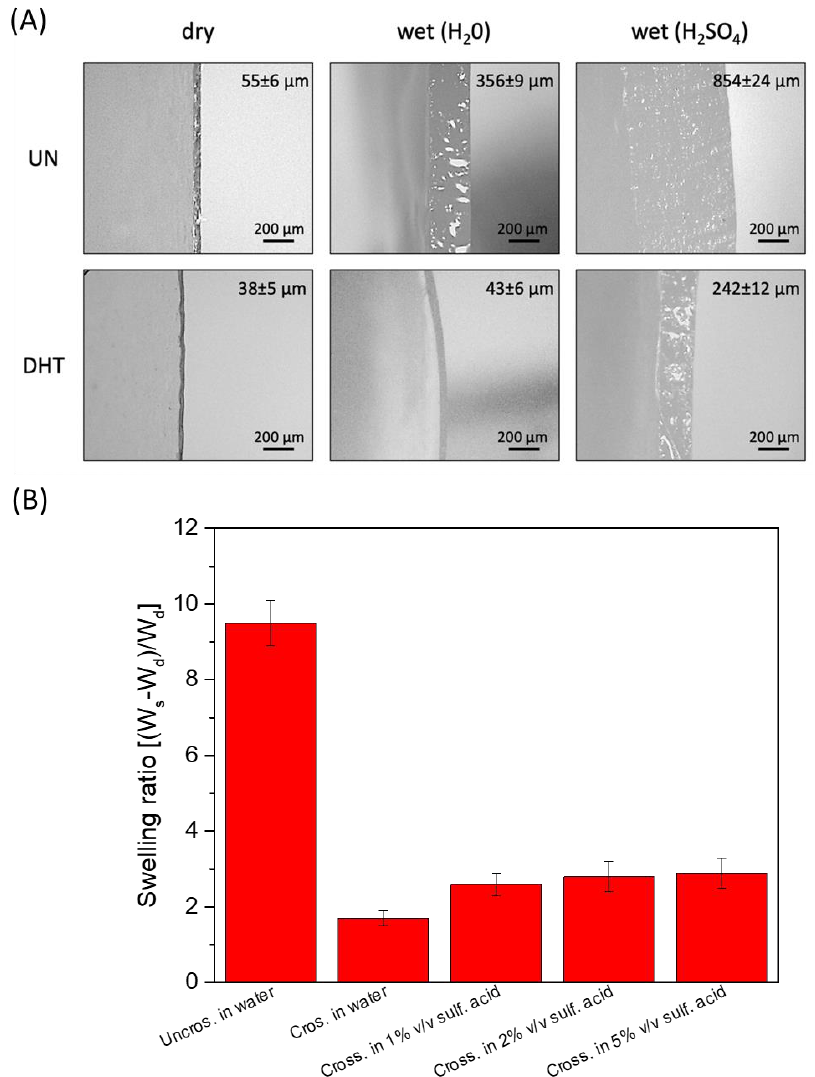
Figure 4. ( A ) Representative snapshot of uncrosslinked and cross-linked collagen matrices thickness in a dry state and in the presence of water and of sulfuric acid 1% ( v / v ). ( B ) Swelling degree of uncrosslinked and cross-linked collagen matrices thickness in a dry state and in the presence of water and of 1–5% ( v / v ) H 2 SO 4 .